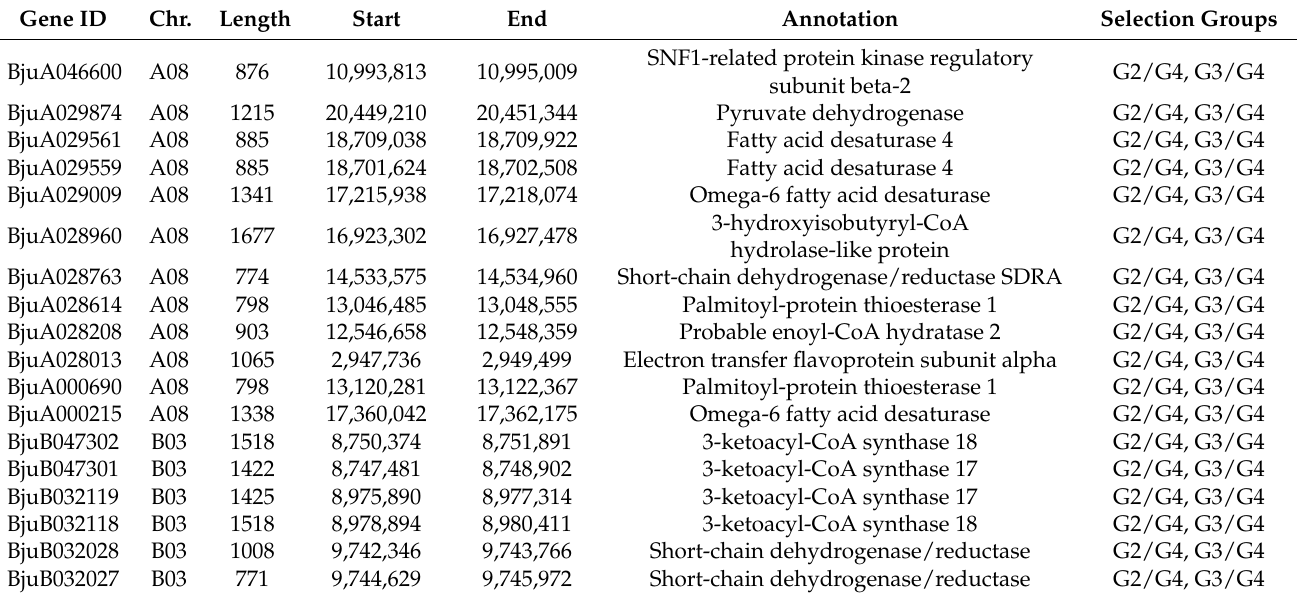
Table 3. Genes associated with fatty acid